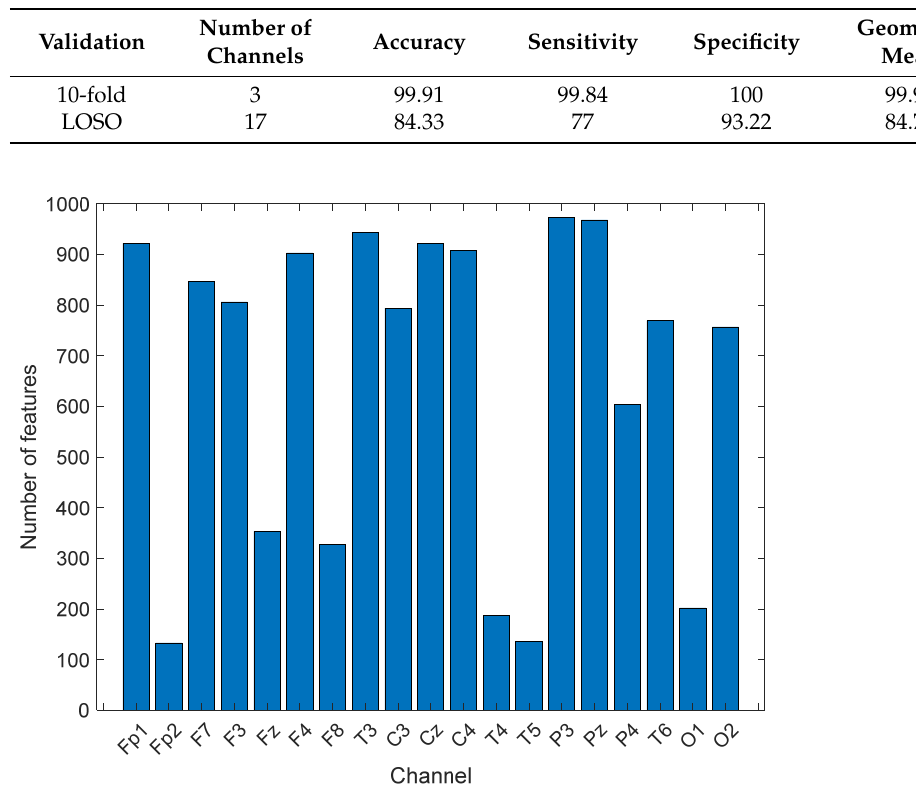
Table 7. The calculated voted results (%) according to the 10-fold cross-validation and LOSO cross-validation.